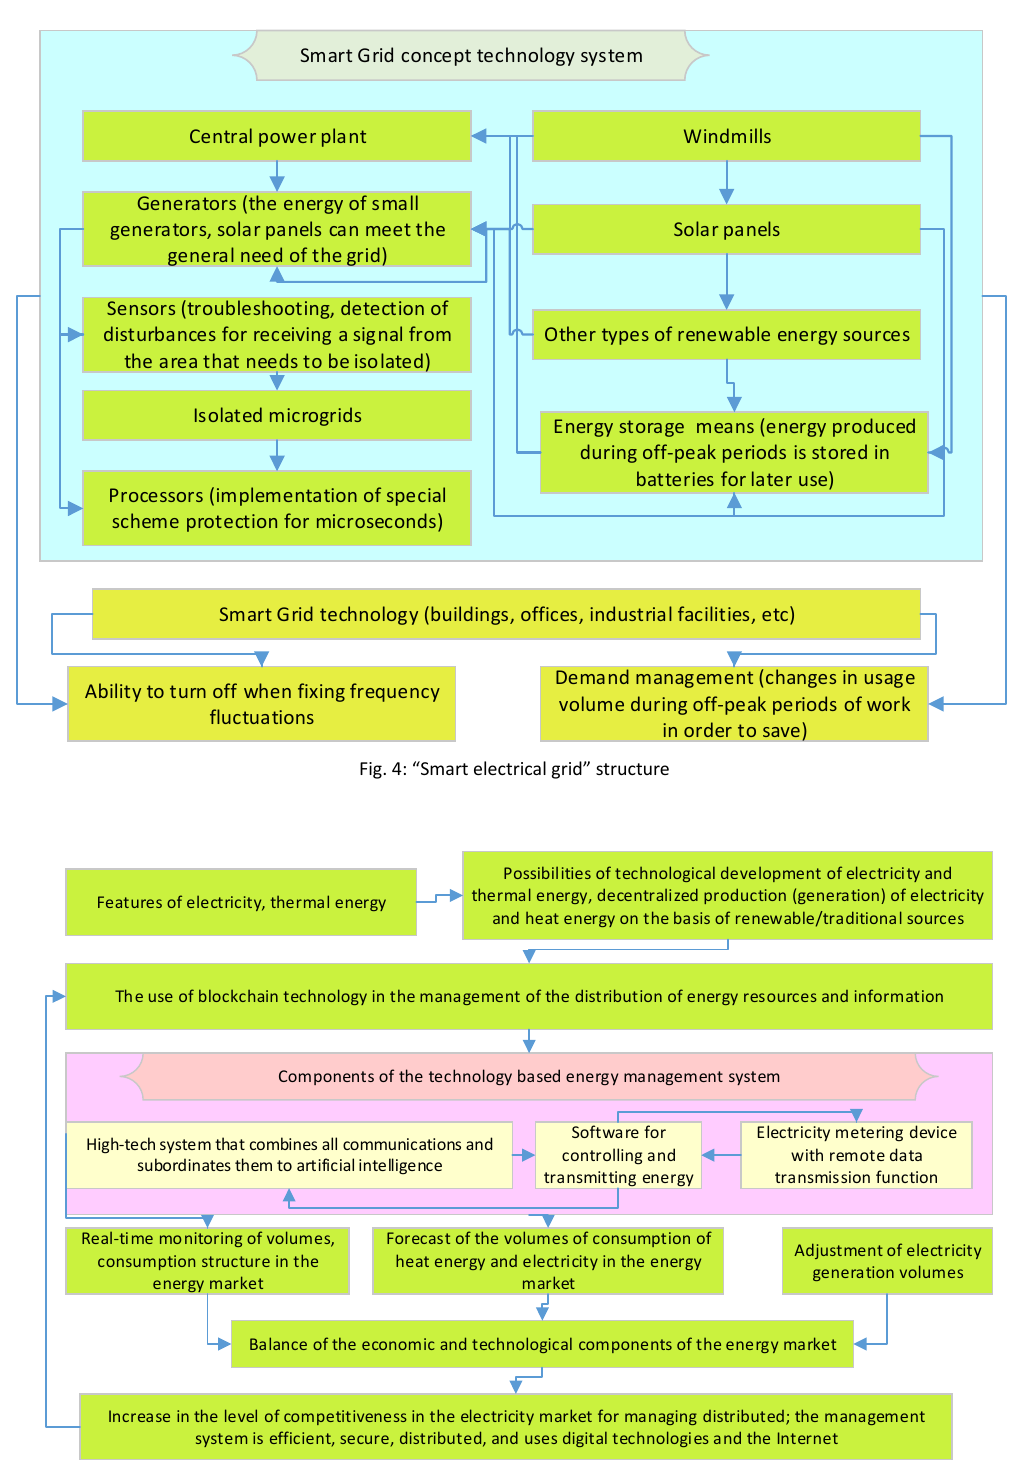
Fig. 5: Blockchain technology management system